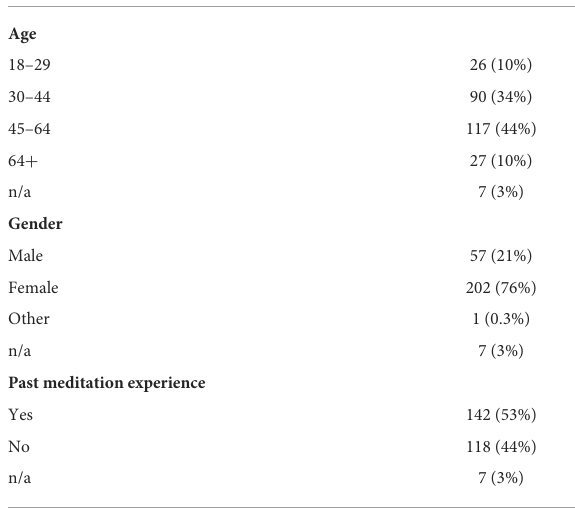
TABLE 1 Baseline characteristics of all participants initially enrolled in the